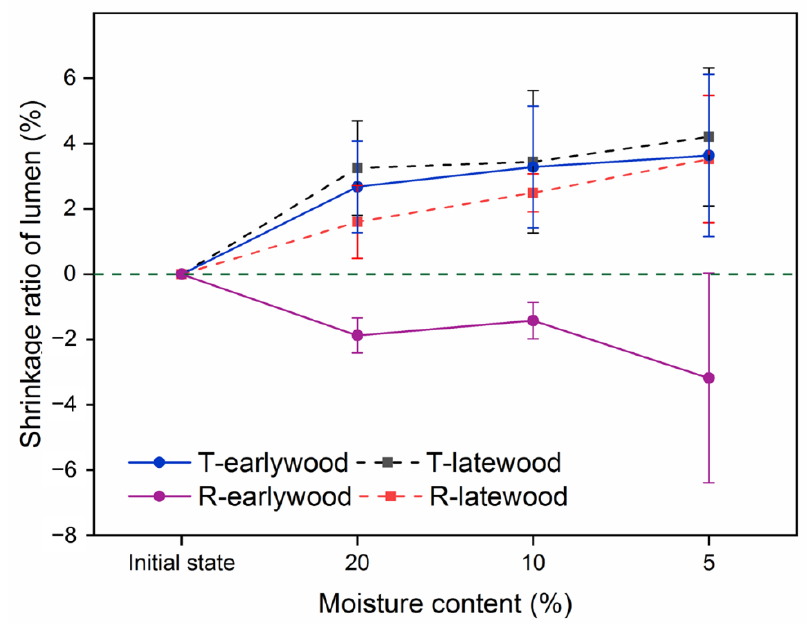
Figure 7. The shrinkage ratio of the cell lumen in the tangential and radial directions of early- and latewood.